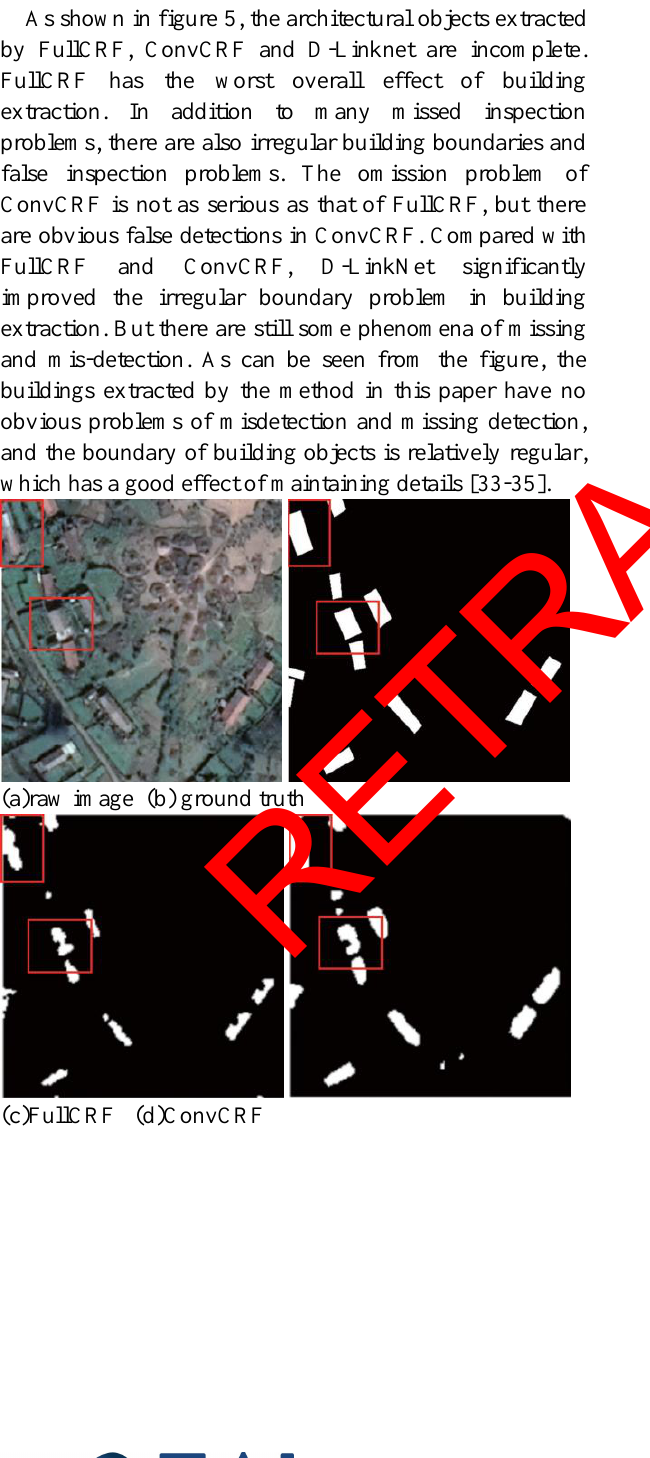
(e)D-LinkNet (f) Proposed